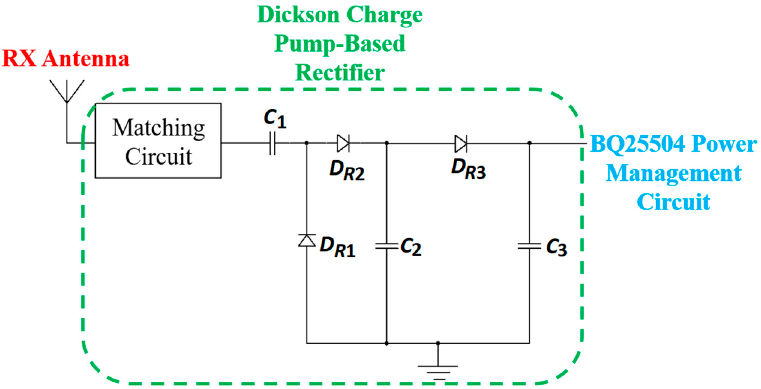
Figure 37. RX power processing unit for RFF [165].